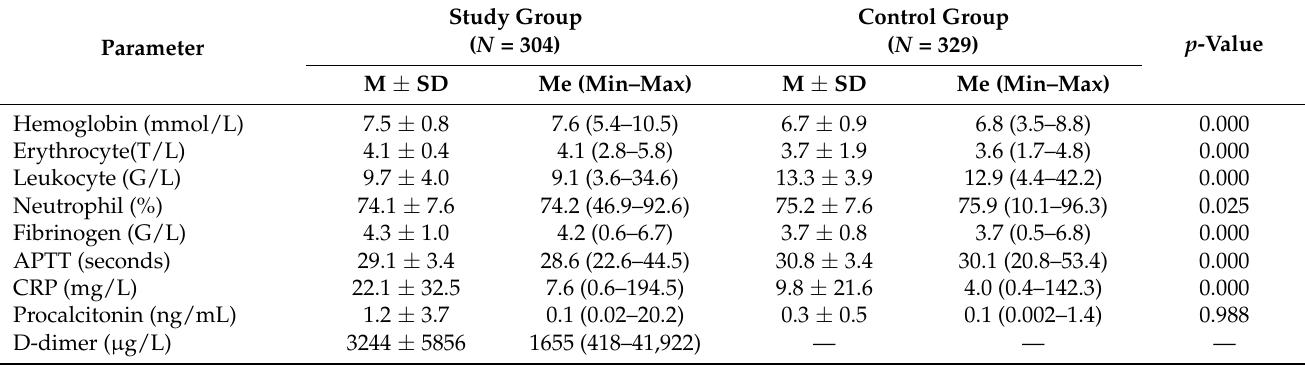
Table 2. Maternal blood parameters.